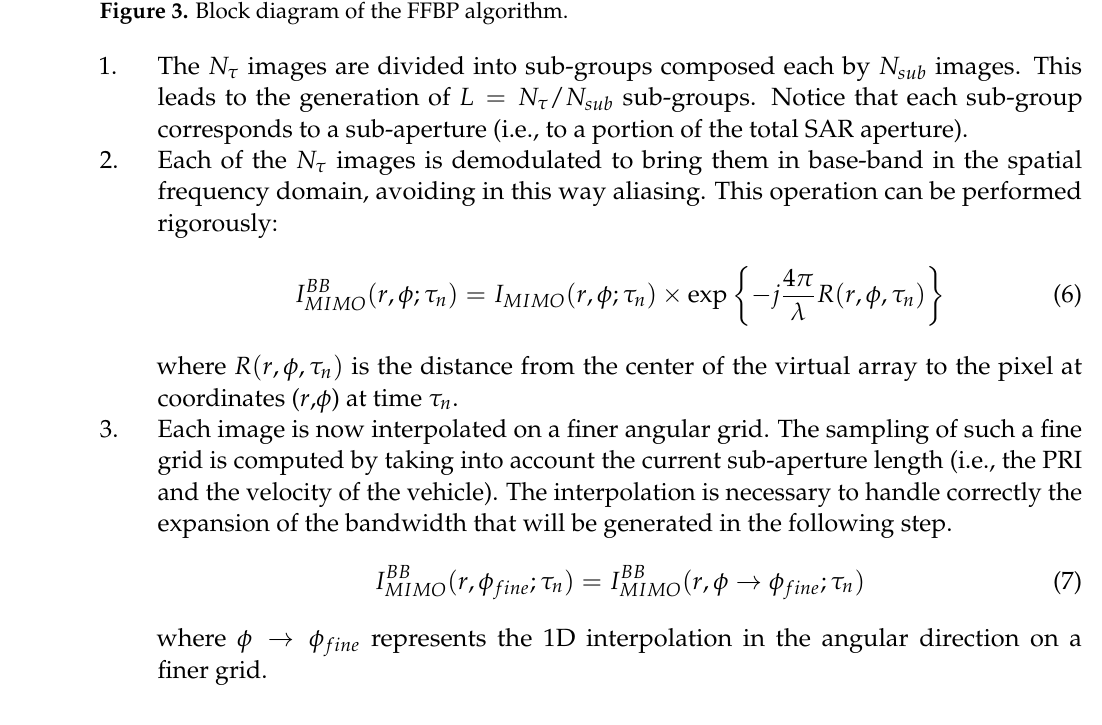
Figure 3. Block diagram of the FFBP